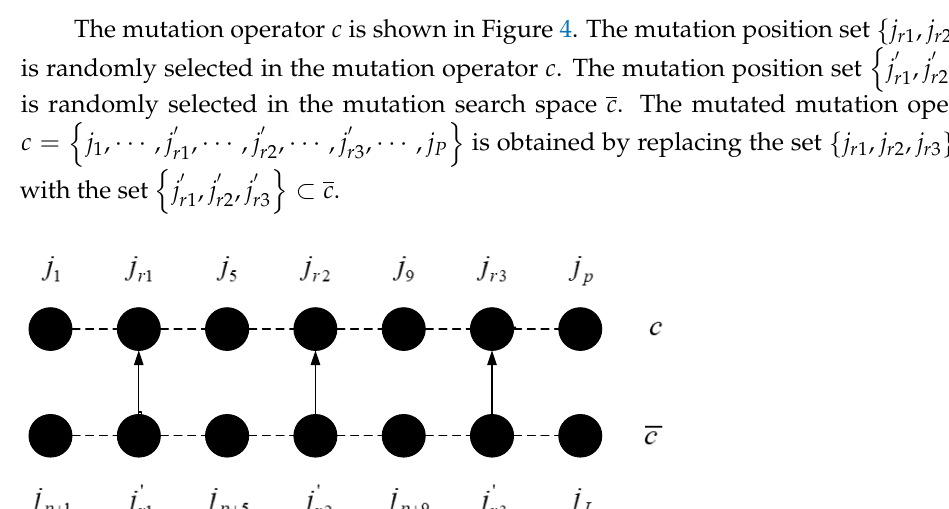
Figure 4. The mutation process of the mutation operator 𝑐 .